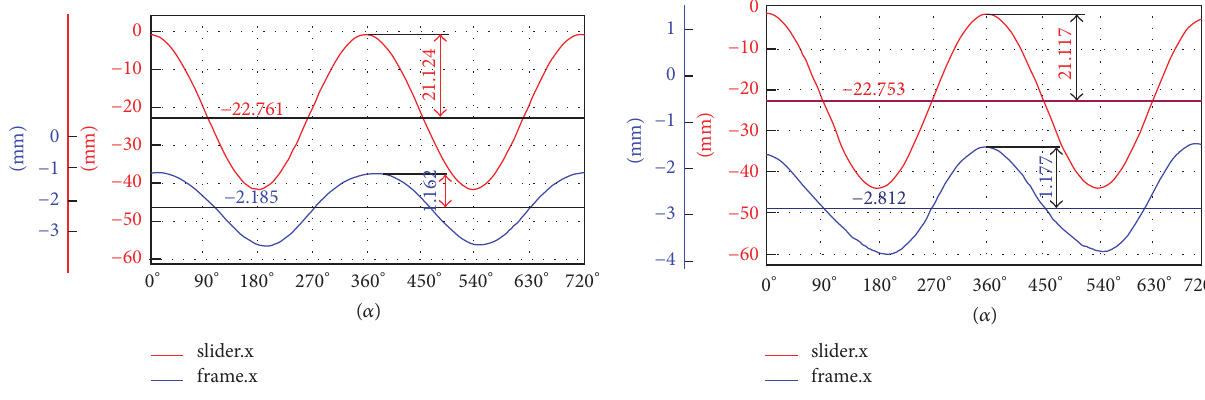
(b) Displacement curves of the frame and slider under the condition of stamping Figure 11: Displacement curves of the frame and slider without the installation of